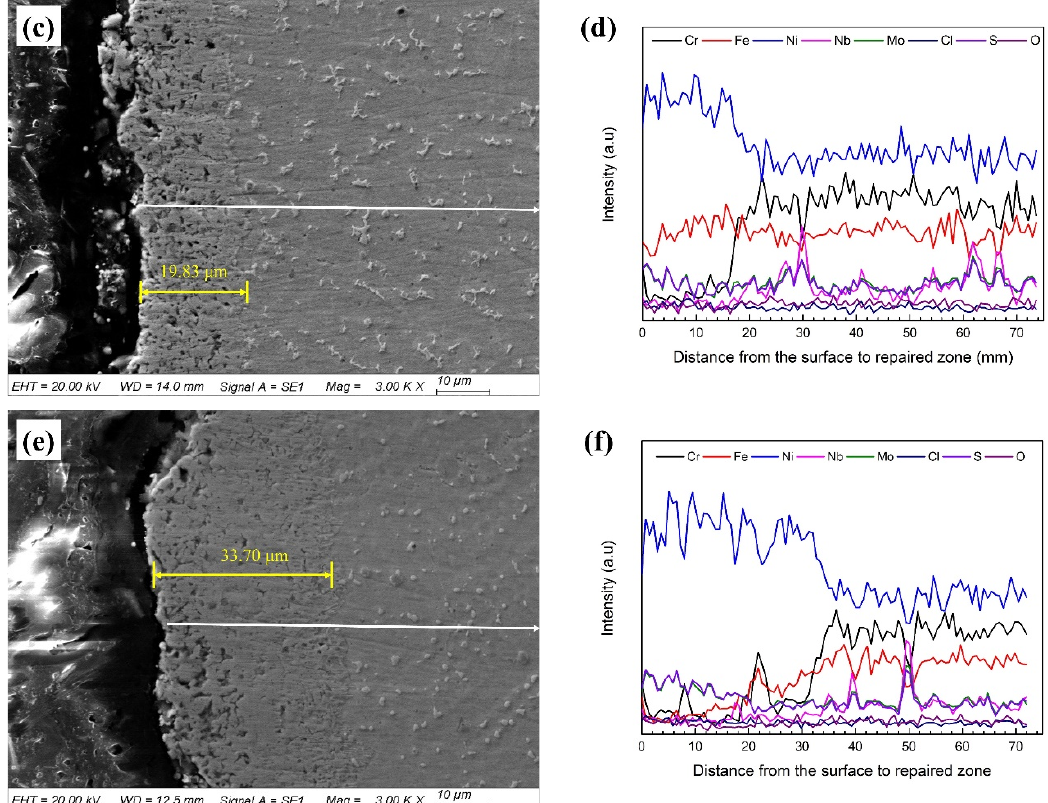
Figure 7. Cross-sectional SEM micrographs and corresponding linear analysis results of the repaired Inconel 718 specimen after the hot corrosion for 50 h ( a ) SEM image and ( b ) element distribution, for 100 h ( c ) SEM image and ( d ) element distribution, and for 150 h ( e ) SEM image and ( f ) element distribution.